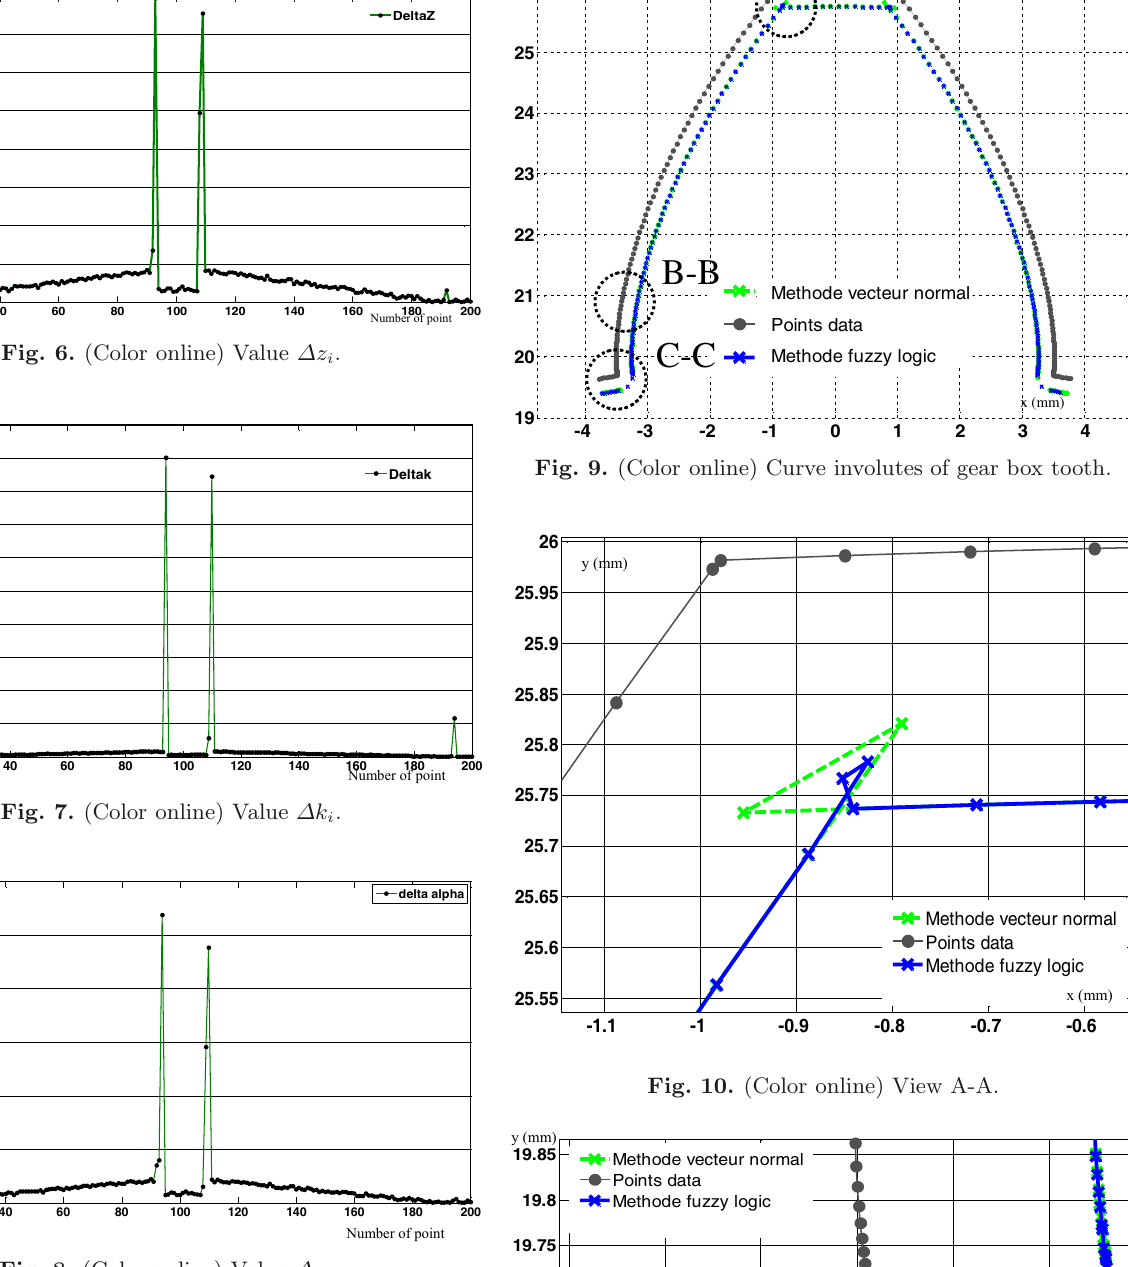
Fig. 8. (Color online) Value Δα i .